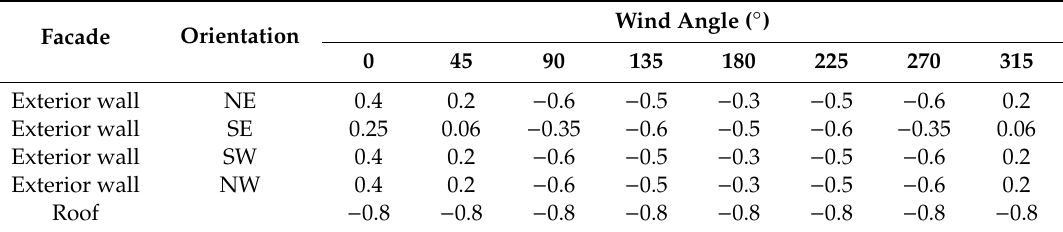
Table 2. Facade average wind pressure coe ffi cients used in the building